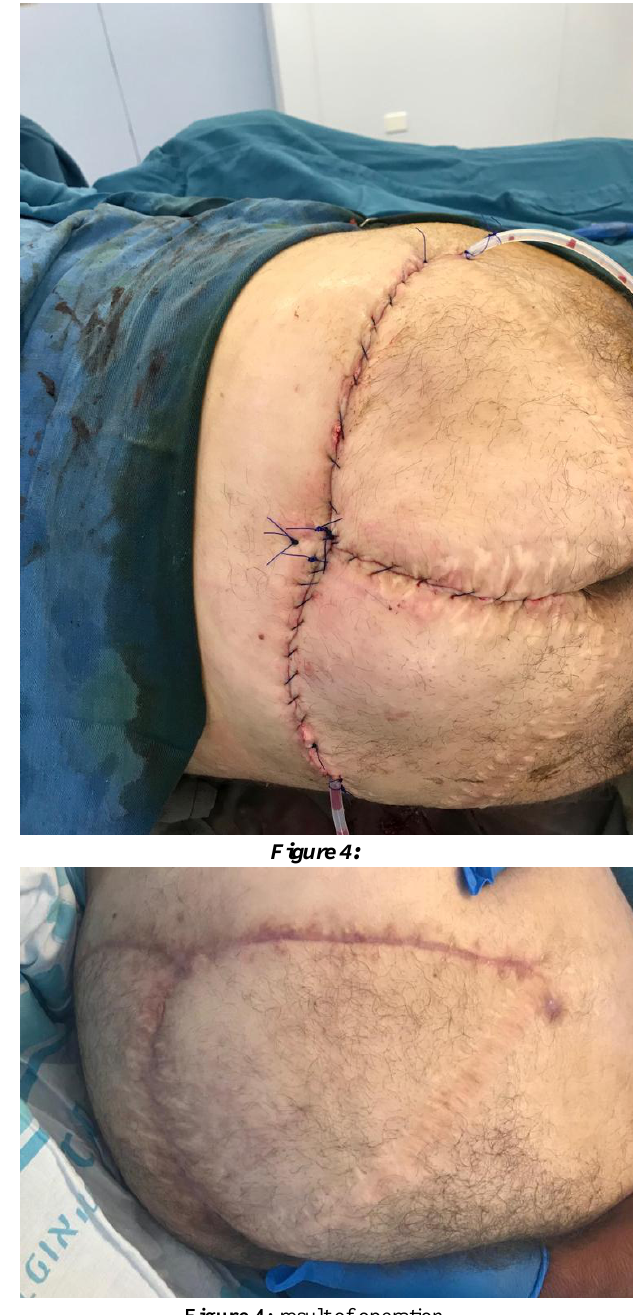
Figure 4: result of